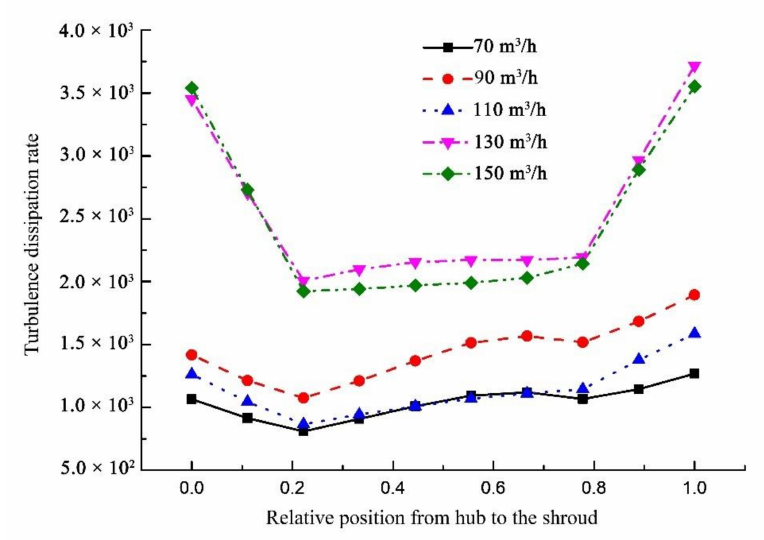
Figure 16. The variation of turbulence dissipation rate from the hub to the shroud of the first impeller middle section under different flow rates.